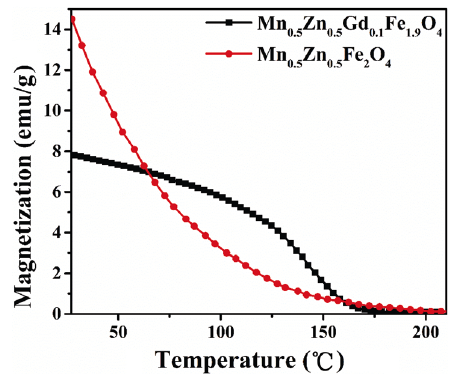
Fig. 6 Magnetization versus temperature at 500 G for Mn 0.5 Zn 0.5 Gd x Fe 2– x O 4 ( x = 0 and 0.1)